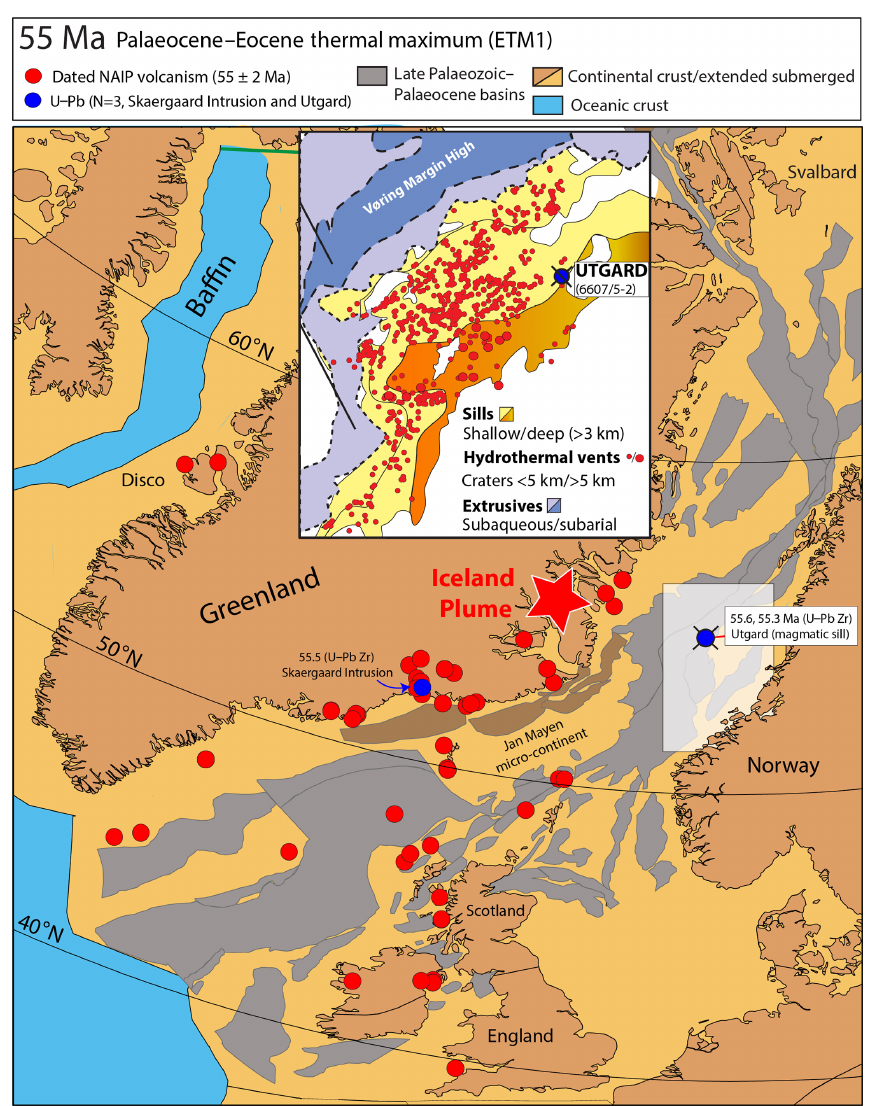
Figure 2. Reconstruction of the northeast Atlantic at 55Ma with the distribution of dated (57–53Ma) onshore and offshore sample locations (red filled circles) for the North Atlantic Igneous Province, the location of the Iceland Plume with respect to Greenland (Torsvik et al., 2015), and rift basins developed from the late Palaeozoic to the Palaeocene (Faleide et al., 2010). The inset map demonstrates the extensive sill and hydrothermal vent complexes in the Vøring Basin off the shore of Norway (see white box in main map) and the location of the 6607/5-2 Utgard borehole, where magmatic sills intruding organic-rich sediments are dated to 55.6 and 55.3Ma (U–Pb zircon; Svensen et al., 2009). From a database of many hundreds of dated volcanics and intrusions there are only six U–Pb ages, ranging from 62 . 6 ± 0 . 6Ma (Antrim lower basalt in Ireland) to 56.02Ma (Skaergaard intrusion in eastern